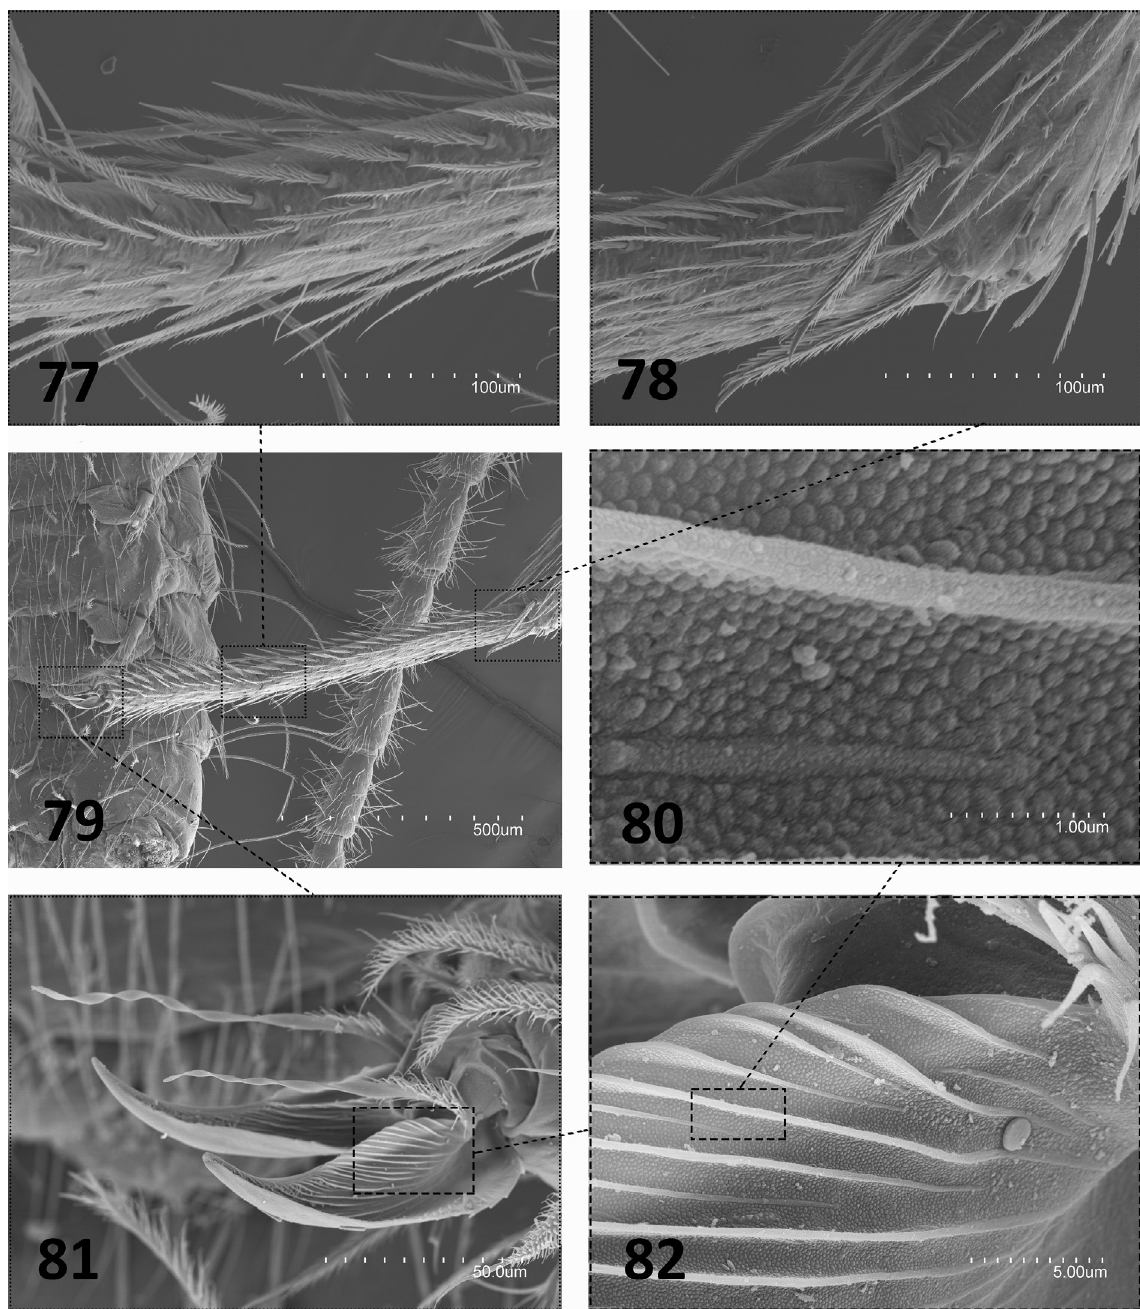
Figs 77–82. Plusiocampa ( Plusiocampa ) hoffmanni Sendra & Paragamian sp. nov., metathoracic leg of ♀ from Varathro Stou Bokou ton Poro, Krousonas, Crete (Coll. AS). 77 . Medial portion of tarsus in latero-ventral view, with a visible pseudo-articulation. 78 . Joint between tibia and tarsus with their calcars. 79 . Tarsus. 80 . Detail of ventral side of anterior claw, lateral view. 81 . Pretarsus, lateral anterior view. 82 . Anterior claw,